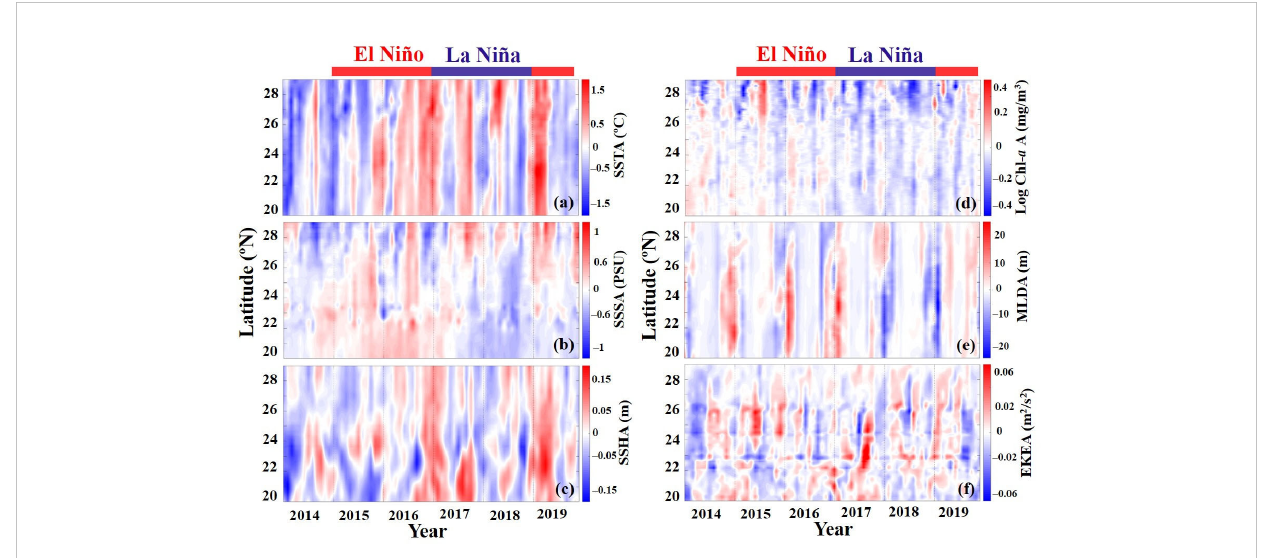
FIGURE 6 Hövmöller plot of anomalies in six environmental variables; (A) sea surface temperature anomaly (SSTA), (B) sea surface salinity anomaly (SSSA), (C) sea surface height anomaly (SSHA), (D) Log chlorophyll- a anomaly (Log Chl- a A), (E) mixed layer depth anomaly (MLDA), and (F) eddy kinetic energy anomaly (EKEA) during El Niño and La Niña events in the Taiwan Strait in 2014 –